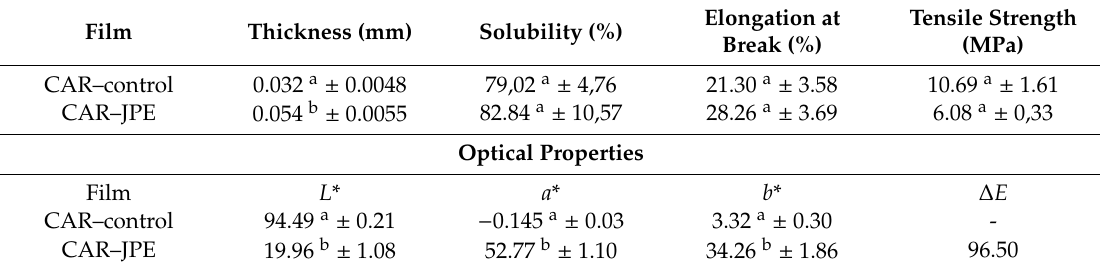
Table 4. Thickness, solubility, mechanical properties, and optical properties of films.